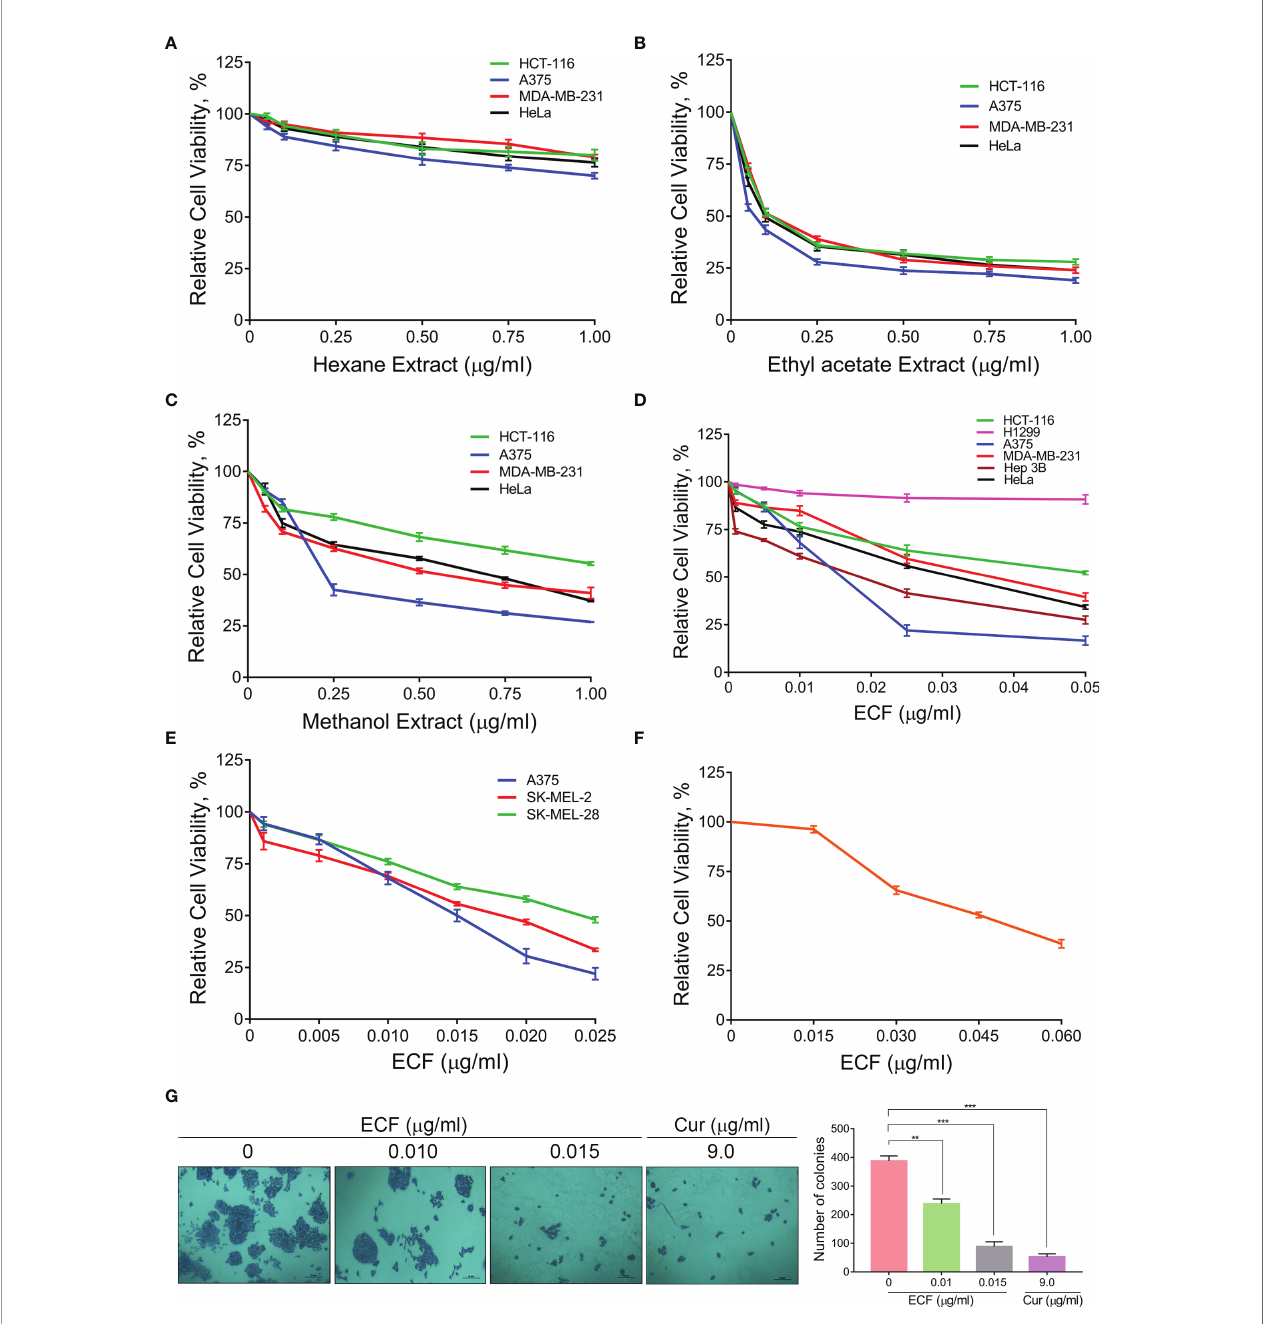
FIGURE 1 | ECF, a bioactive fraction of C. epigaeus rhizome induces cytotoxicity in melanoma cells (A – C) Cytotoxicity assessment of the C. epigaeus rhizome-derived organic extracts on cancer cells of various tissue origins. (D) Cell viability analysis upon treatment by ECF bioactive fraction as assessed in various cancer cell lines. (E, F) Cytotoxicity induced by ECF on melanoma cell lines in comparison to normal skin fi broblast, FS cells. (G) ECF inhibits the proliferative potential of A375 cells. Data are representative of three independent experiments (Mean±SEM) and P-values are calculated using one way ANOVA. ***P ≤ 0.001, **P ≤ 0.01 and ns ≥